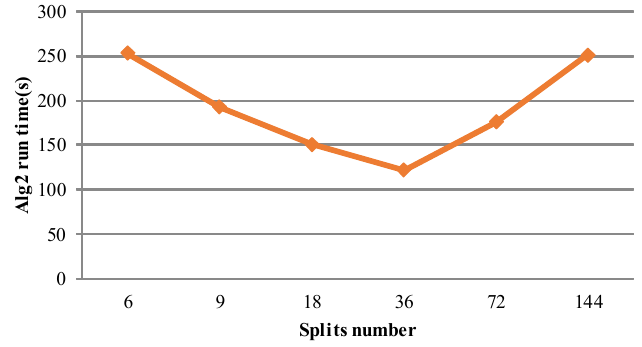
Figure 8. The relationship between split number and simulation time.